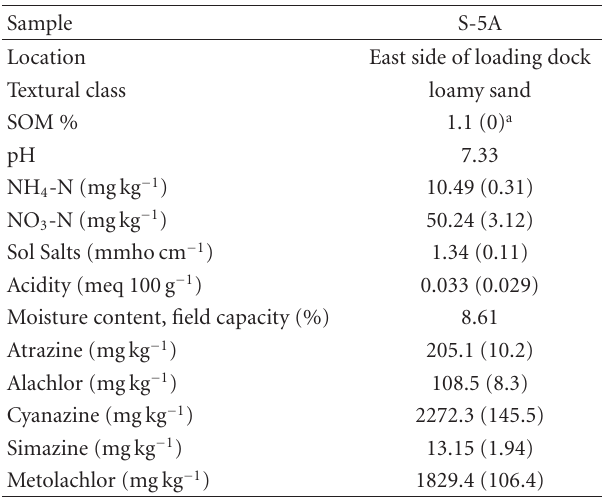
Number in parentheses represents standard deviation of 3